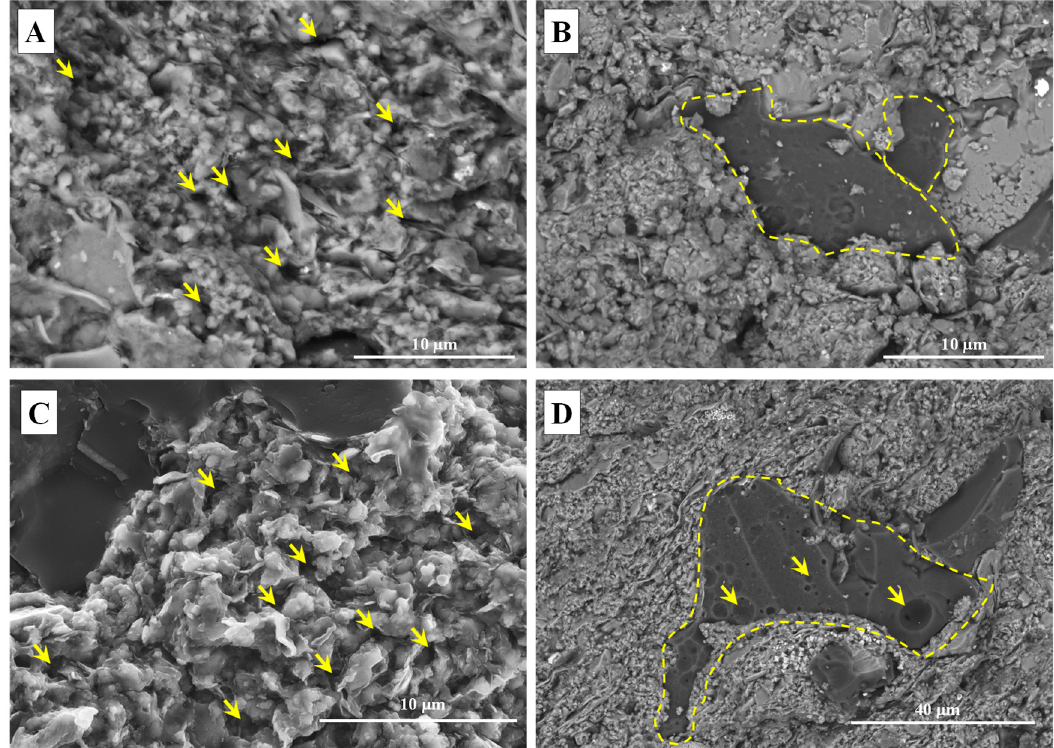
Figure 4. SEM images of the samples before the experiment: ( A ) voids in the sample #12, ( B ) organic matter in sample #12; ( C ) voids in the sample #16/18, ( D ) porous organic matter in the sample #16/18. Appl. Sci. 2020 , 10 , x FOR PEER REVIEW